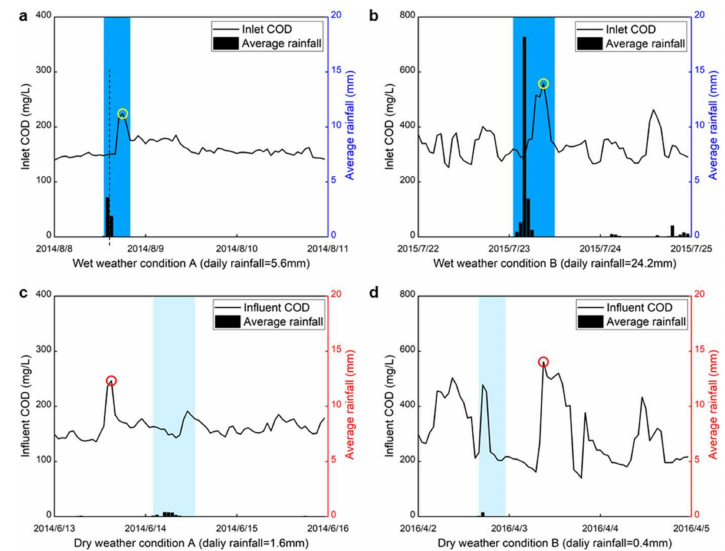
Figure 7. Hourly influent COD of the WWTP during two wet (a-b) and two dry (c-d) weather conditions. The plotted rainfall measurement is the hourly average of seven gauges in the catchment. Shaded areas represent estimated rainfall runoff durations. Yellow and red circles refer to observed peak